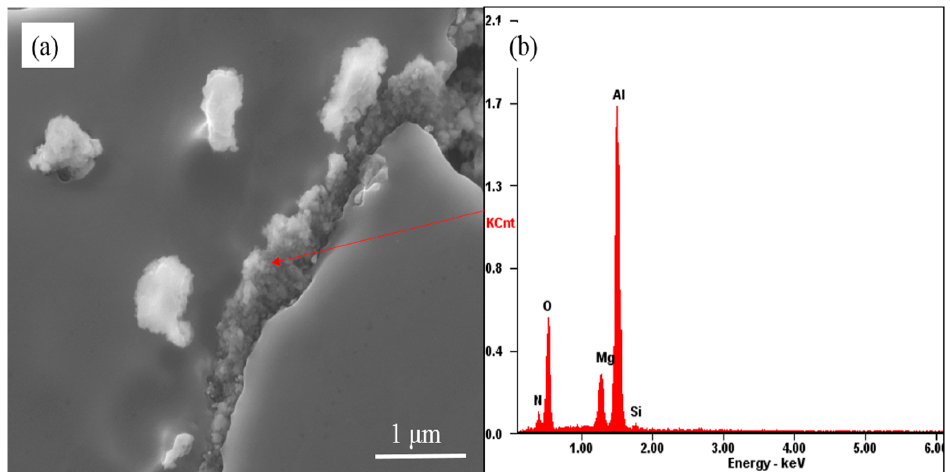
Figure 5. ( a ) The micro-morphology of A356 alloy scraps after being held in the commercial pure aluminum melt for 15 min; ( b ) Corresponding EDS results.